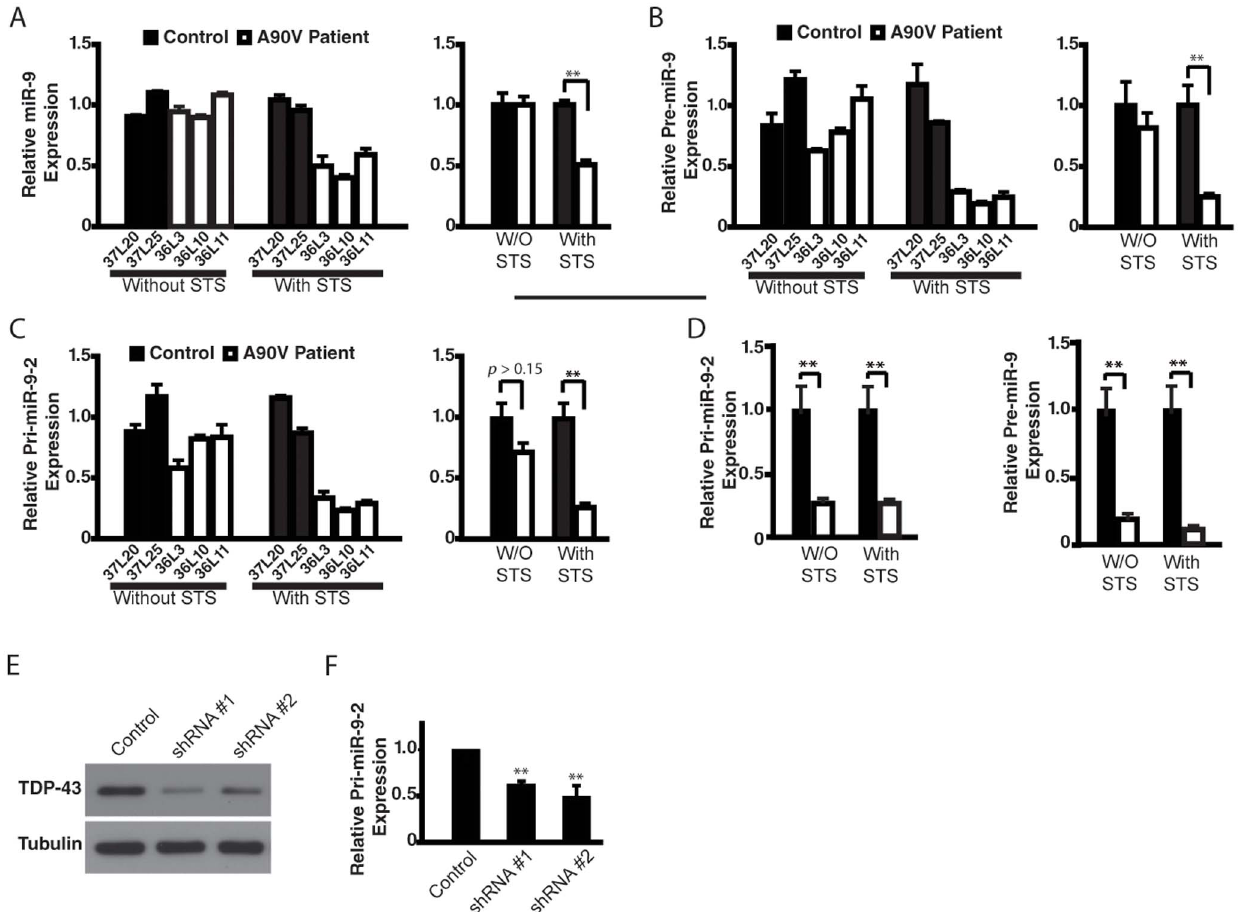
Figure 6. Expression of miR-9 and its precursors is reduced in patient neurons under stress. ( A ) Relative expression levels of mature miR- 9 in neurons derived from two control and three patient iPSC lines containing the A90V mutation with or without STS treatment (left panel). The averages in control and patient neurons are shown on the right. ( B ) Expression of pre-miR-9. ( C ) Expression of pri-miR-9-2. The average of different lines from the same individual is set as 1. The results in A–C were confirmed from additional two independent neuronal differentiation experiments. ( D ) The relative expression levels of pri-miR-9-2 and pre-miR-9-2 in neurons derived from two patient iPSC lines containing the TARDBP M337V mutation was reduced. This result is based on two independent differentiation experiments. ( E ) TDP-43 levels were greatly decreased in primary mouse neurons transfected with two TARDBP shRNAs. ( F ) Expression of pri-miR-9-2 is decreased in primary mouse neurons transfected with TARDBP shRNA. Values are mean 6 SEM. **: p , 0.01 (Student’s t-test). (Promega) according to the manufacturer’s protocol. All experi- ments were conducted in triplicate.